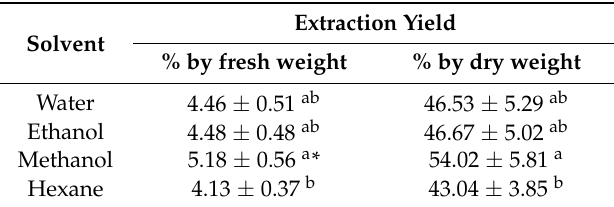
Table 1. Extraction yield of carrot peel extracted by four various